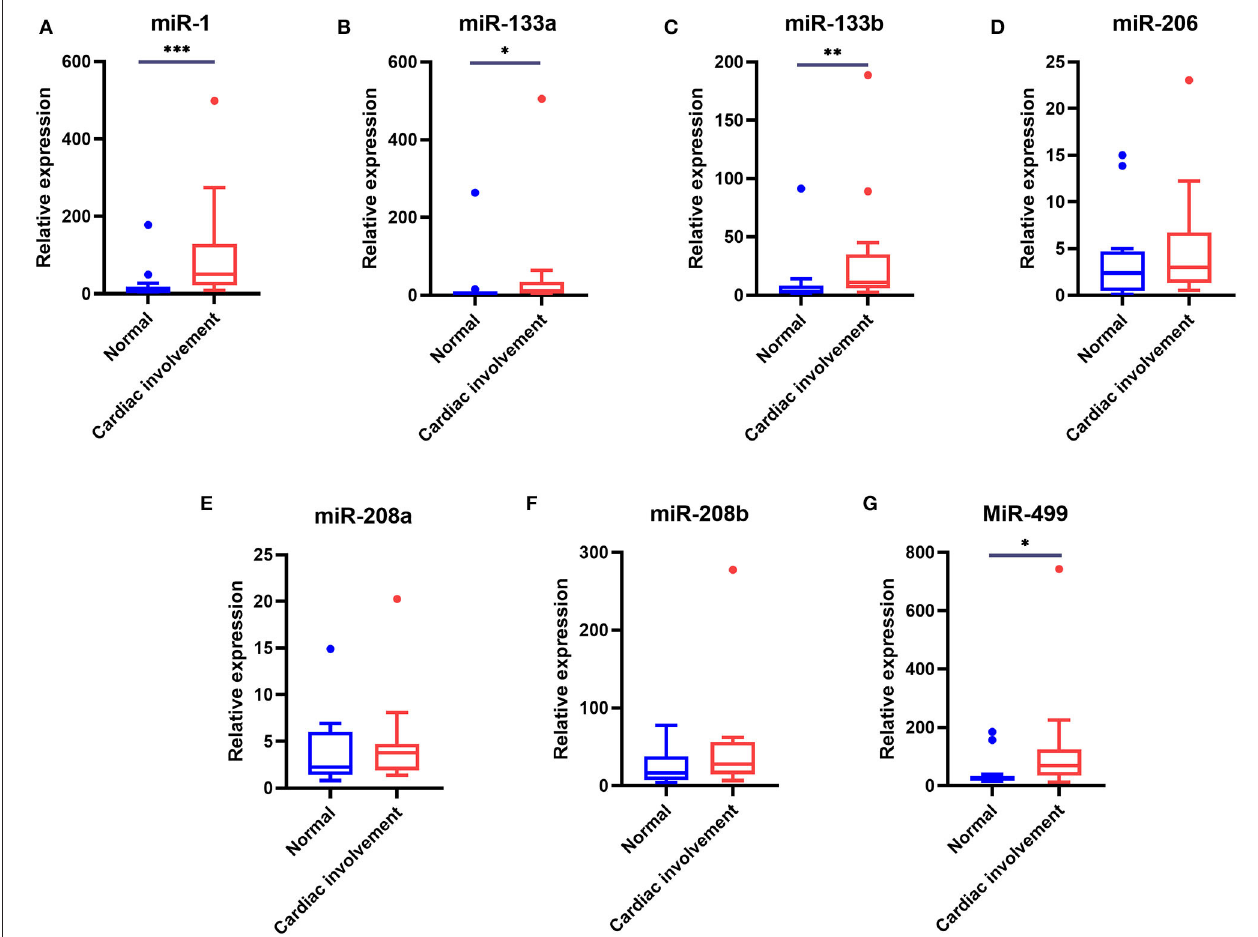
FIGURE 3 | Comparison of the serum levels of myomiRs in DMD patients with cardiac involvement and normal groups. Of the patients who underwent cardiac function evaluation, 13 patients with normal ECG and echocardiography were defined as the normal group, 15 patients with one or more abnormalities were defined as the cardiac involvement group. Tukey box plots were drawn to represent the serum levels of myomiRs, miR-1 (A) , miR-133a (B) , miR-133b (C) , miR-206 (D) , miR-208a (E) , miR-208b (F) , and miR-499 (G) , in normal and abnormal groups. The lines in the boxes indicate the median levels, the box limits indicate first and third quartiles, the highest line means Q3 + 1.5 IQR, lowest line means Q1-1.5 IQR, and individual points represent outliers. As data of the two groups were non-normally distributed variables, the non-parametric Mann–Whitney U -test was used for comparison between the two groups. * p < 0.05, ** p = 0.001–0.01, *** p < 0.0001. P < 0.05 was considered statistically significant.